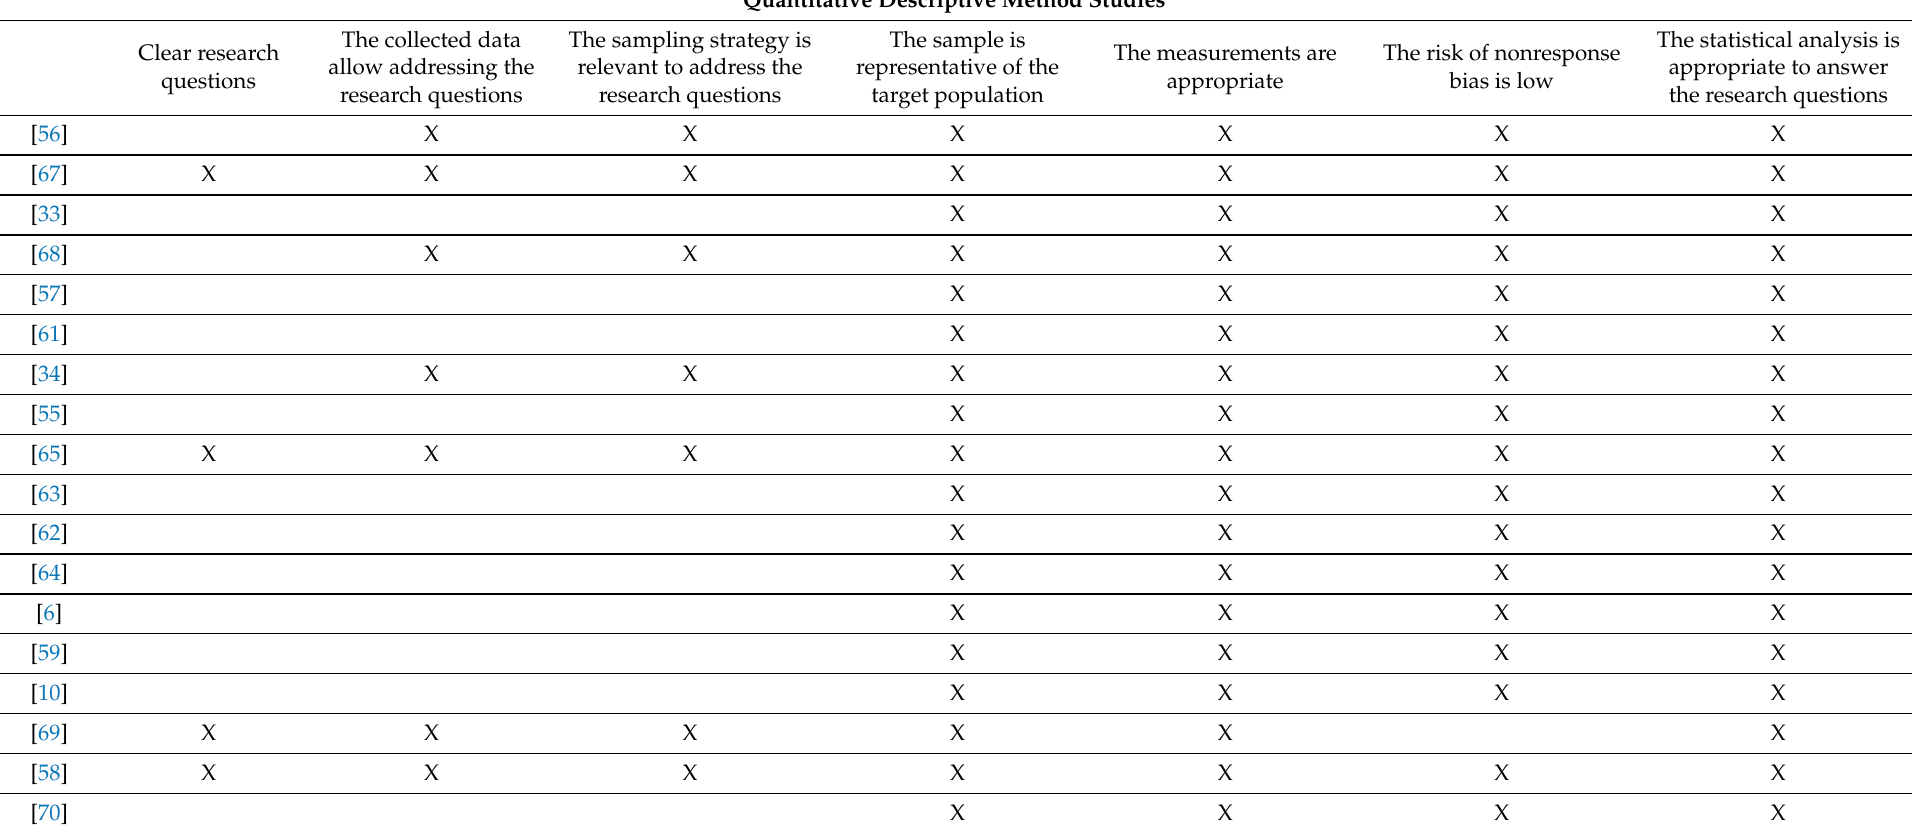
Table 2. MMAT checklist quality assessment